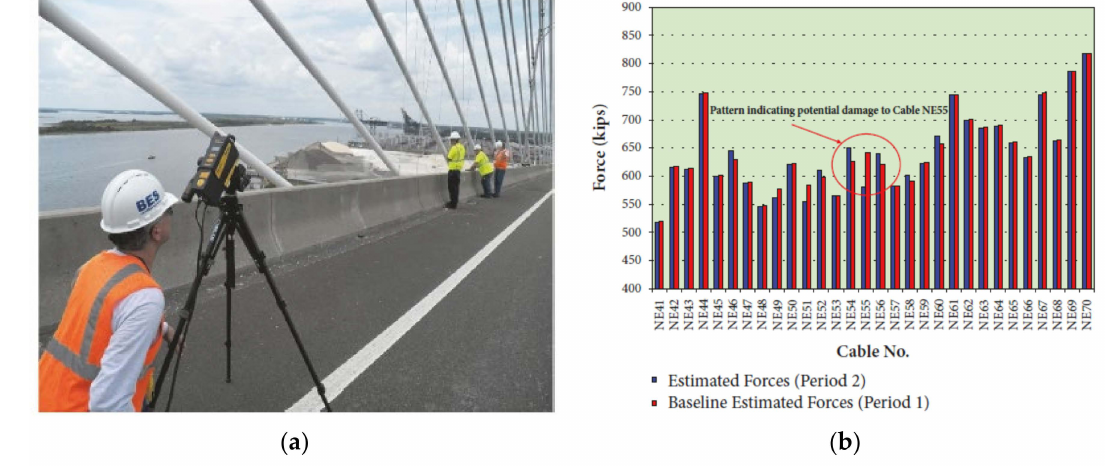
Figure 29. Laser vibrometer targeting cables ( a ); sample force comparison ( b )